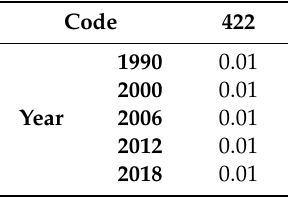
Table 6. Percentage of wetlands according to CORINE land-cover nomenclature for level 3 in Canary Island in 1990, 2000, 2006, 2012 and 2018 (Source: authors).